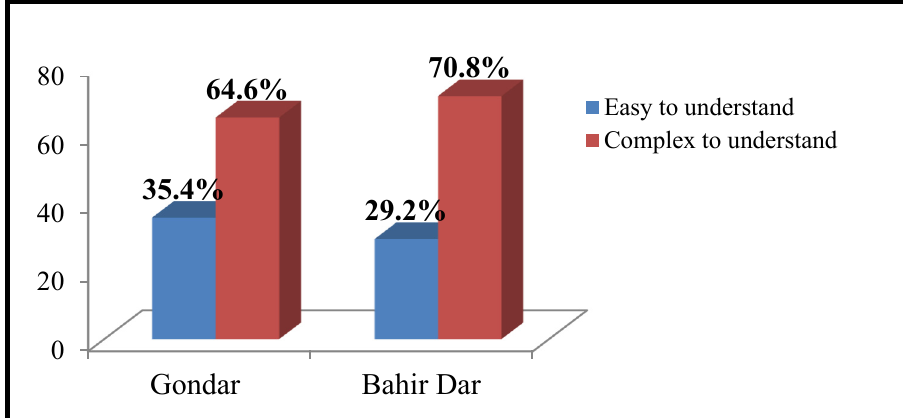
Figure 2. Understanding level of the concept of urban resilience. Source: Field survey, 2021